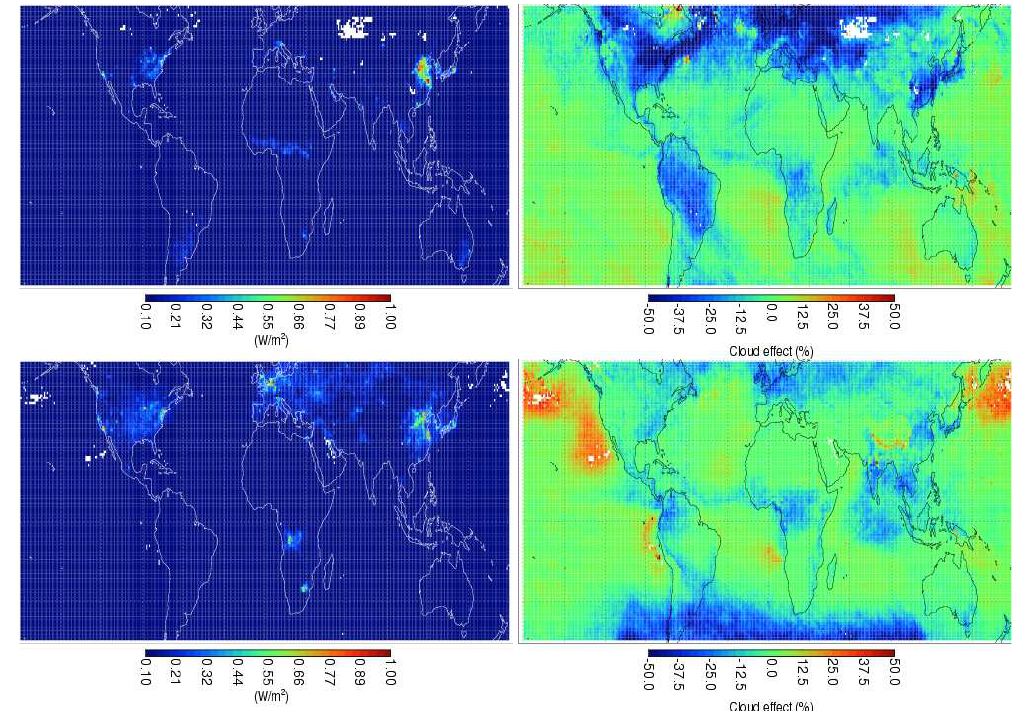
Fig. 7. Clear-sky daily-averaged NAH (left) and cloud effect in % of clear-sky NAH (right) for January (top) and July (bottom) 2005. and the non-linearity of these cloud parameters with respect to the NO 2